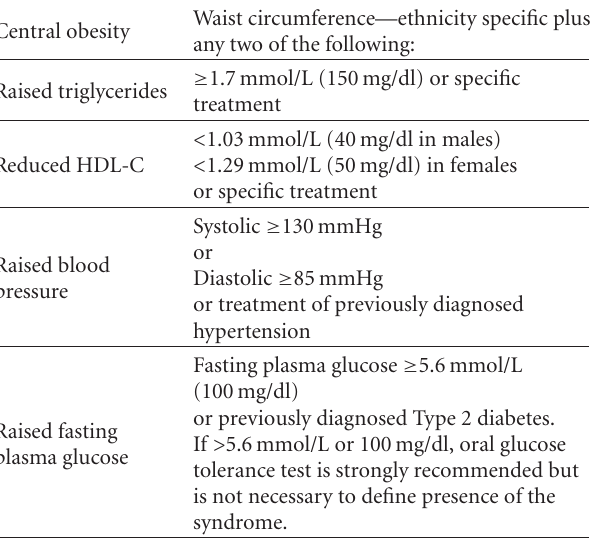
Table 2: International Diabetes Federation (IDF) metabolic syn- drome worldwide definition (IDF, 2006).